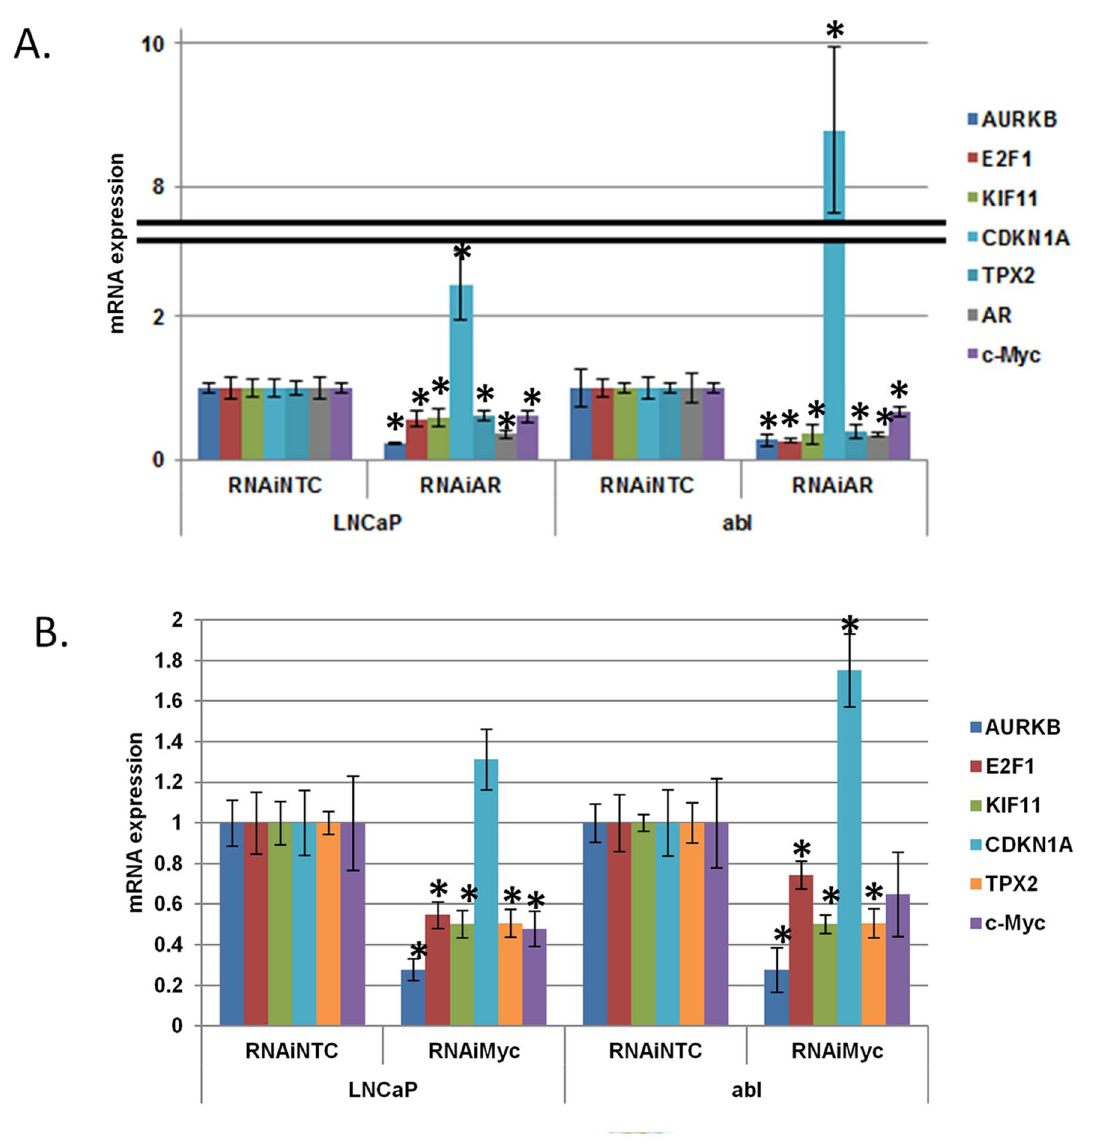
Figure 5. AR suppression recapitulates the effect of c-Myc suppression on c-Myc target gene expression. LNCaP and abl cells were transfected with 50 nM of non-targeted control (NTC) and either A) AR or B) c-Myc RNAi oligonucleotides. Cells were switched to charcoal-stripped serum on the day of transfection and harvested 96 hours later. QRT-PCR was performed to determine the levels of the indicated c-Myc target genes relative to actin . *denotes p , 0.05 compared to